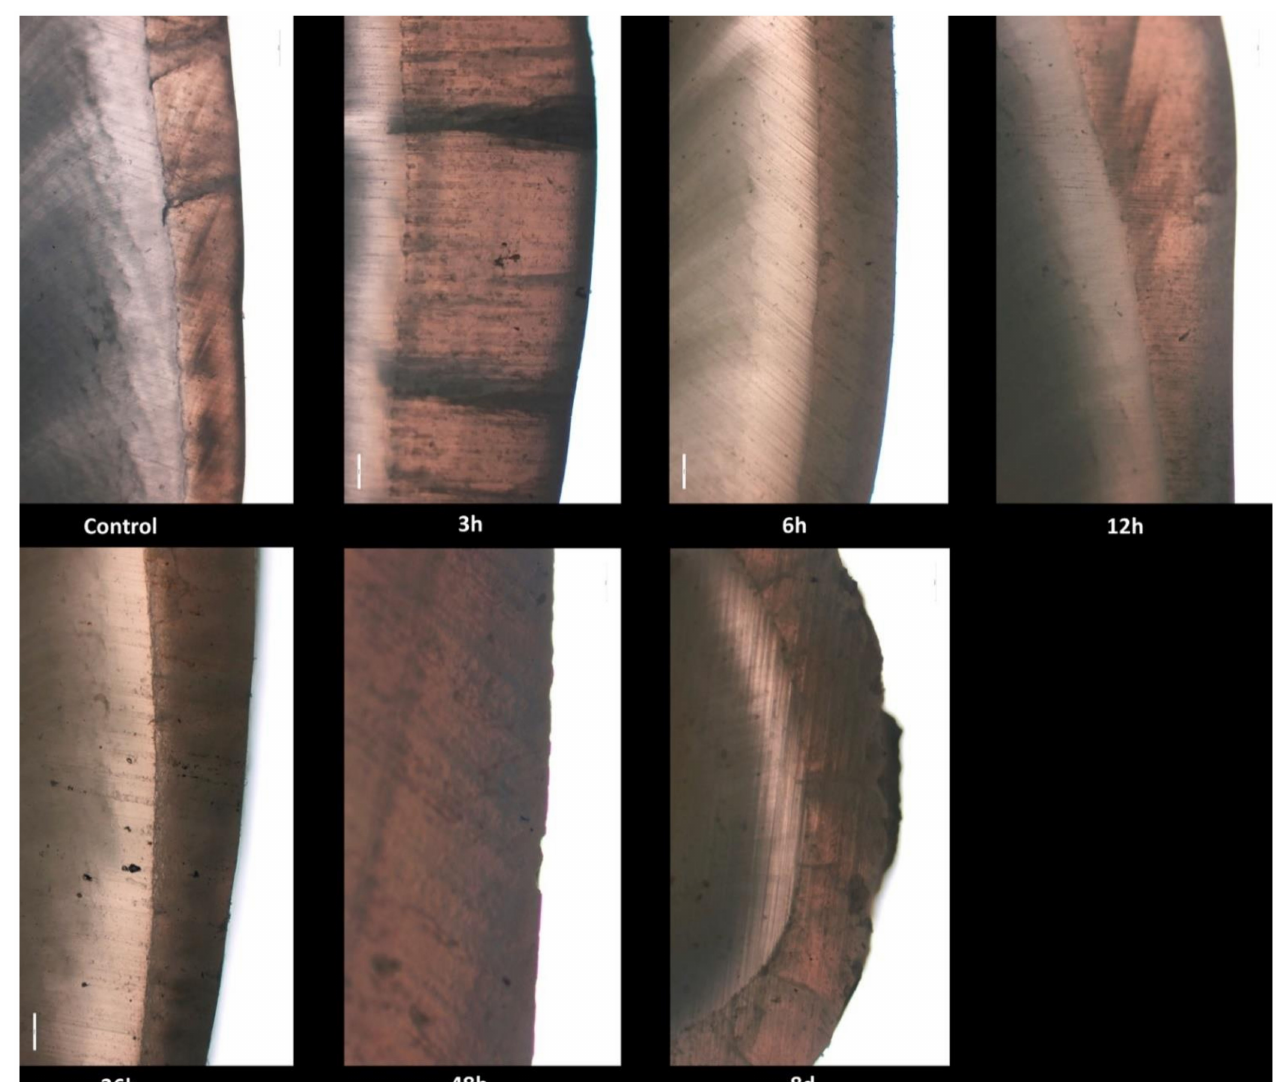
Figure 1. Photomicrographs of enamel and dentin surface morphology in the control group and radioiodine exposed groups at 3, 6, 12, 36, 48 h and 8